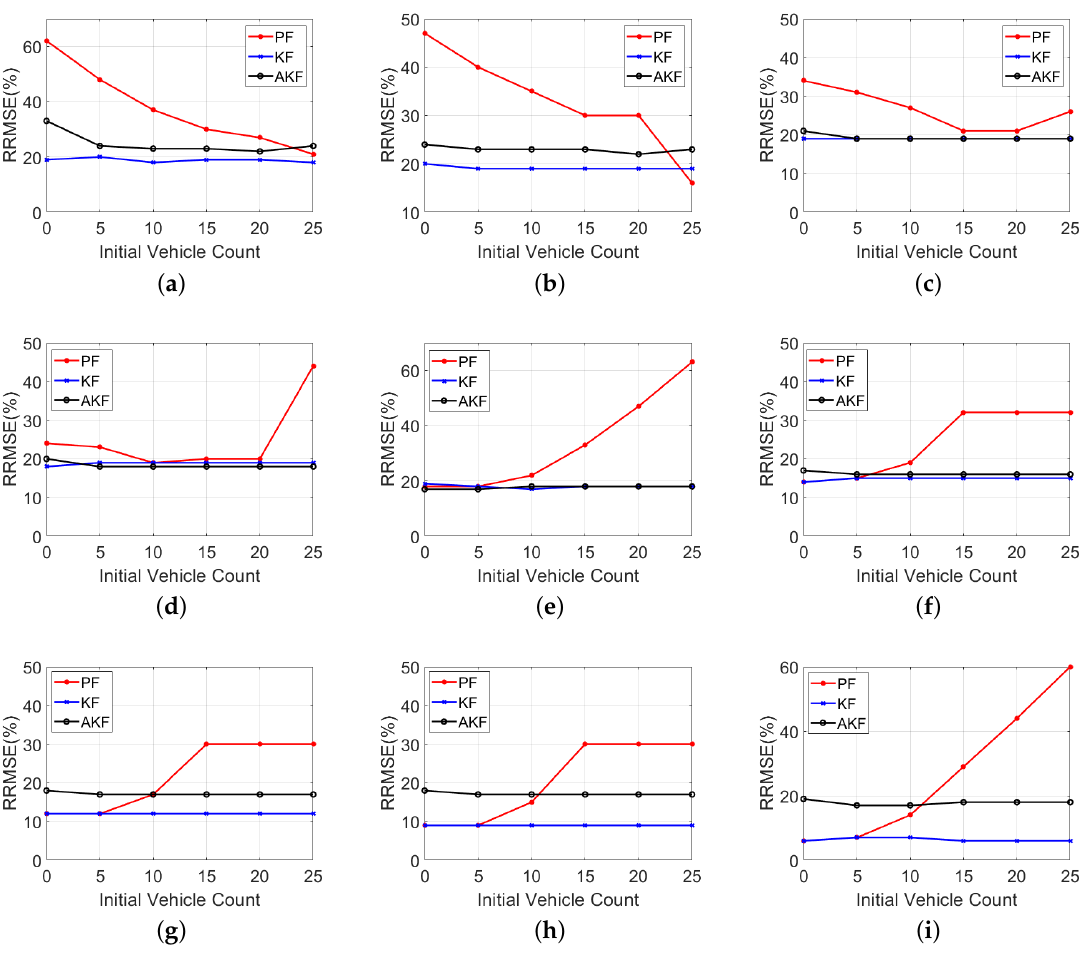
Figure 3. RRMSE values using various initial vehicle count estimates at different LMP scenarios: ( a ) 10%, ( b ) 20%, ( c ) 30%, ( d ) 40%, ( e ) 50%, ( f ) 60%, ( g ) 70%, ( h ) 80% and ( i )